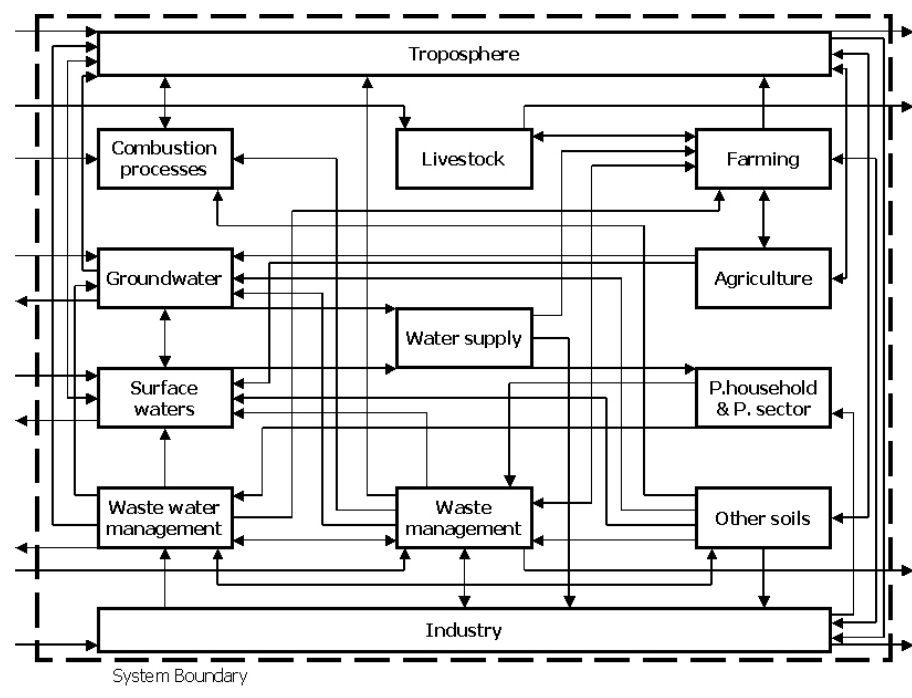
FIGURE 2. System definition as applied for nitrogen compound balance in Catalonia. Each box represents a relevant compartment; arrows stand for nitrogen compound flows.